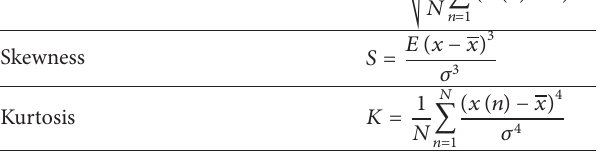
Figure 3: Frequency spectrum under five combinations of different condition patterns. Table 2: Test’s